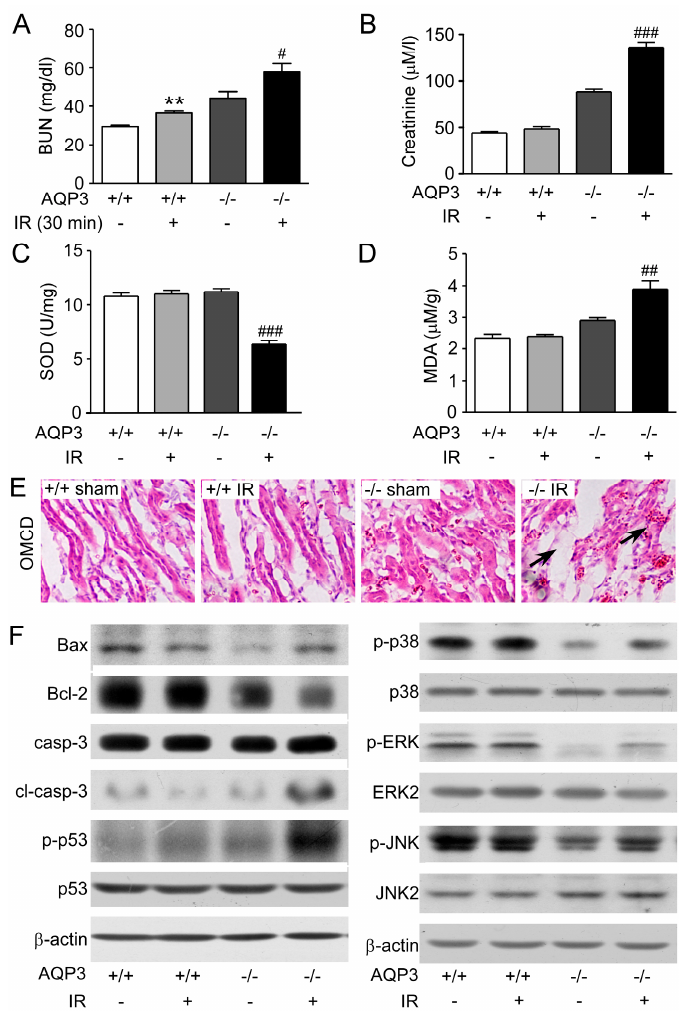
Figure 4. AQP3 deficiency aggravates IR injury. ( A ) Serum BUN level in wild-type and AQP3 − / − mice after reperfusion following 30 min ischemia. ( B ) Serum creatinine level in wild-type and AQP3 − / − mice after reperfusion following 30 min ischemia. ( C ) The activity of SOD in renal tissue. ( D ) The level of MDA in renal tissue. ( E ) Representative outer medullary collecting duct (OMCD) images of H&E staining of wild-type and AQP3 − / − kidneys after sham surgery or I/R. Black arrow represents dilated collecting ducts. ( F ) Different protein expression level of kidneys after reperfusion was detected by Western blot (adapted from Ref [56]).